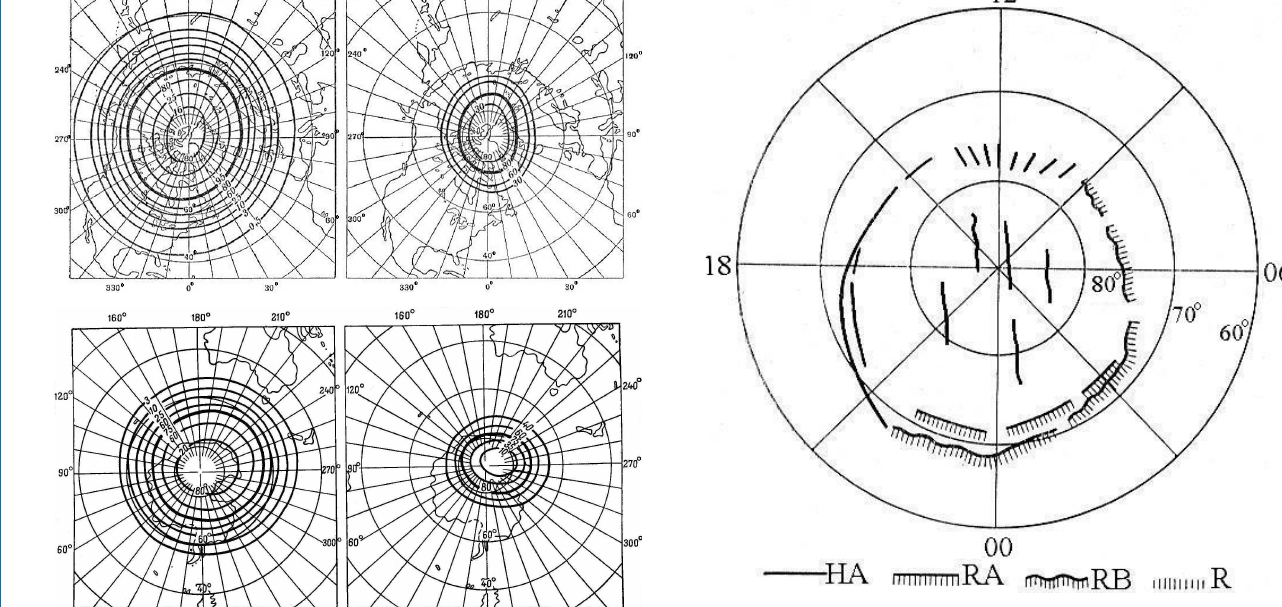
Figure 5. Generalised scheme of discrete auroral forms during quiet intervals according to Feldstein (1966). The labelling is as follows: HA – homogeneous arc, RA – rayed arc, RB – rayed band, and R –